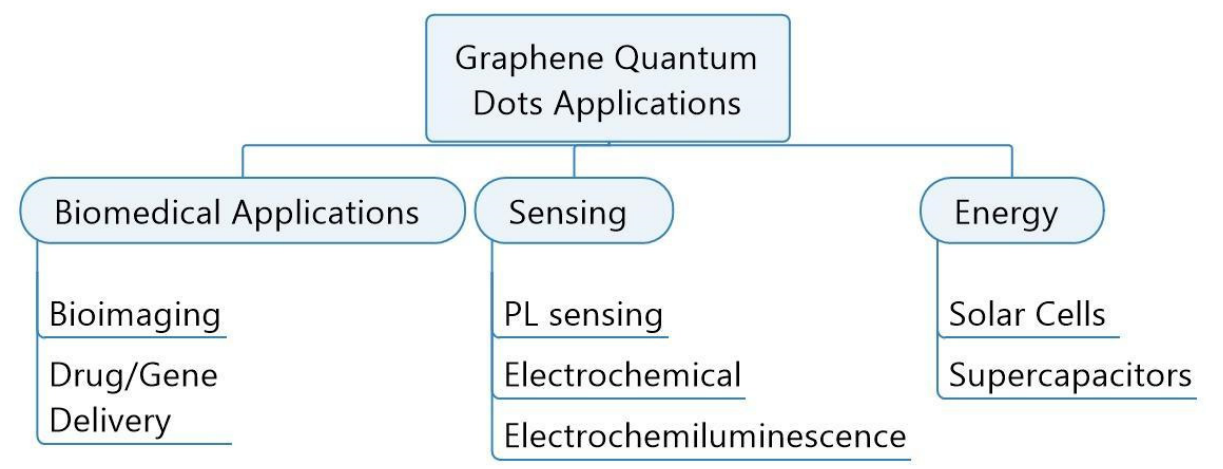
Figure 7. Applications of GQDs.